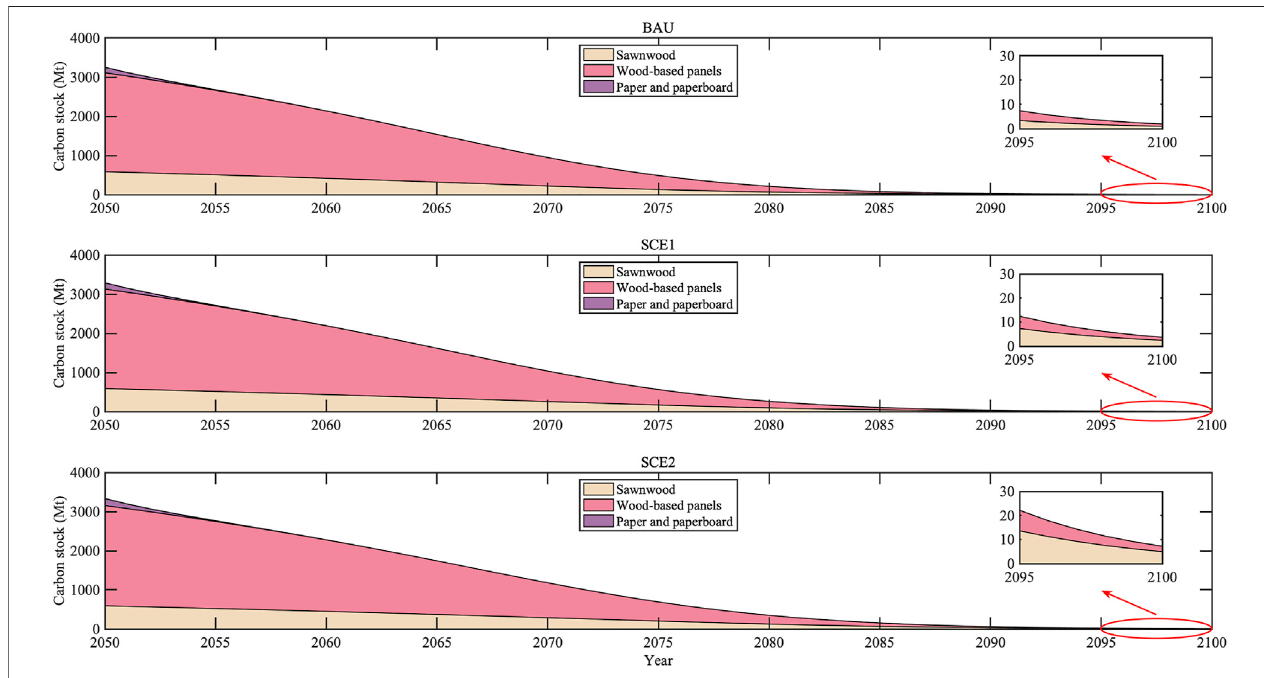
FIGURE 5 | Decay of HWP carbon pool in China from 2050 to 2100.